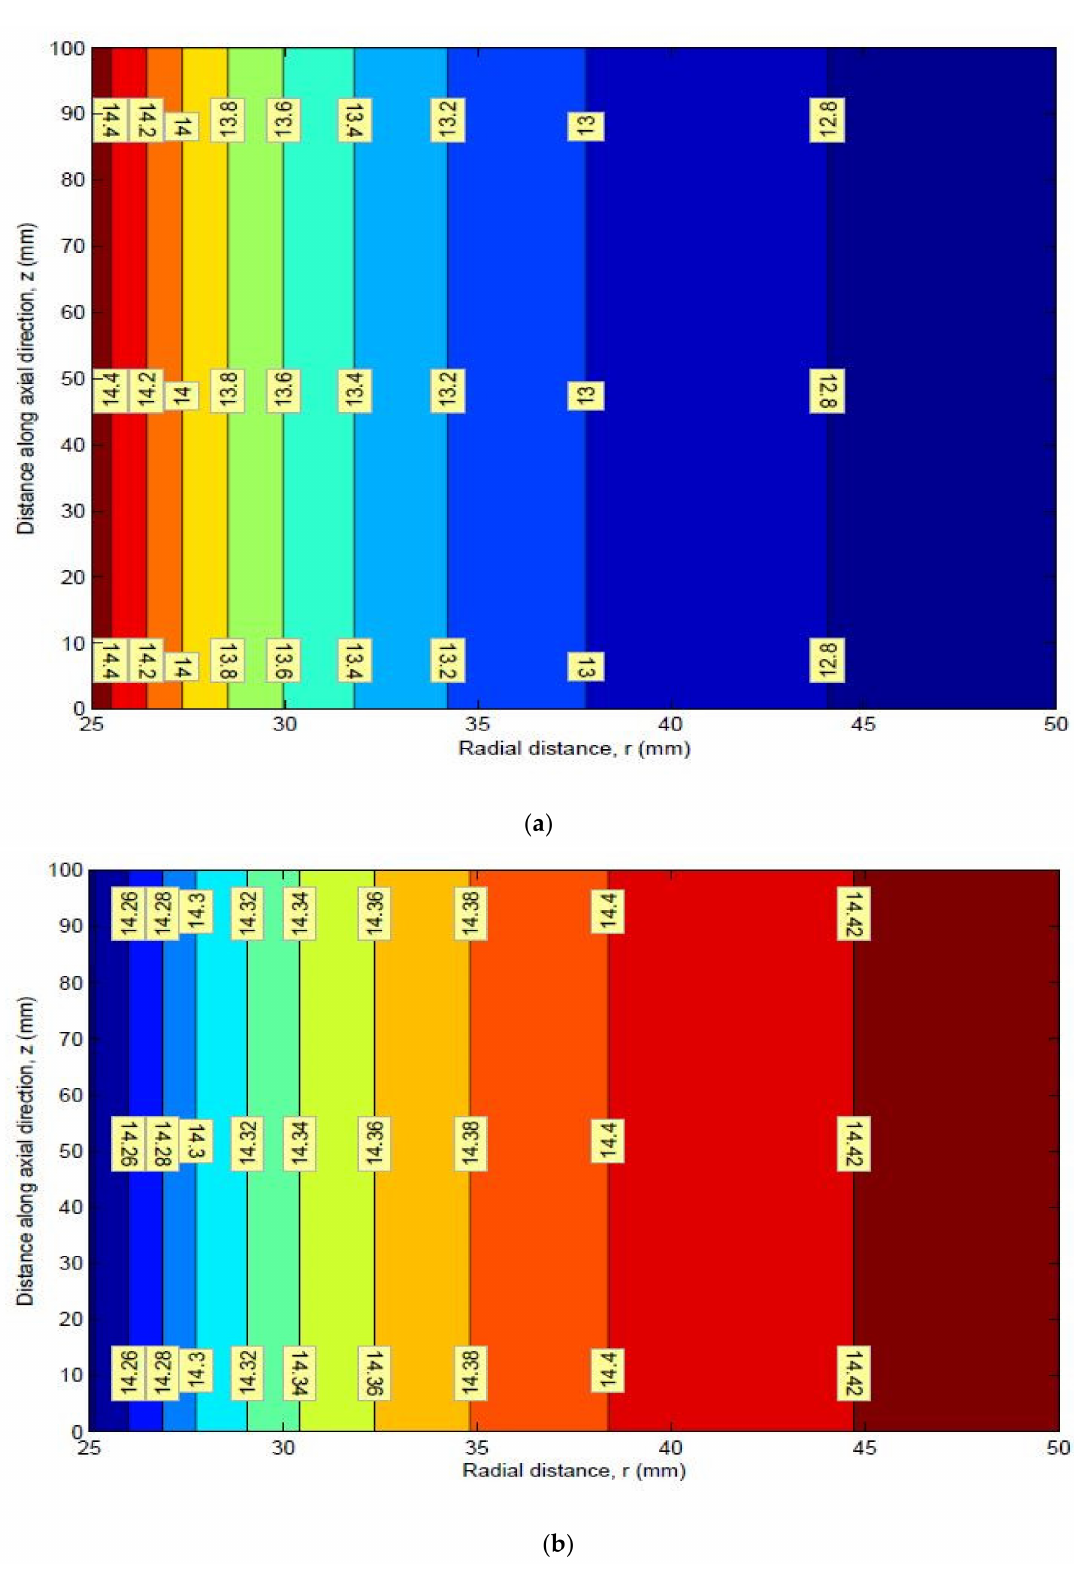
Figure 23. ( a ) Mean and ( b ) standard deviation of axial